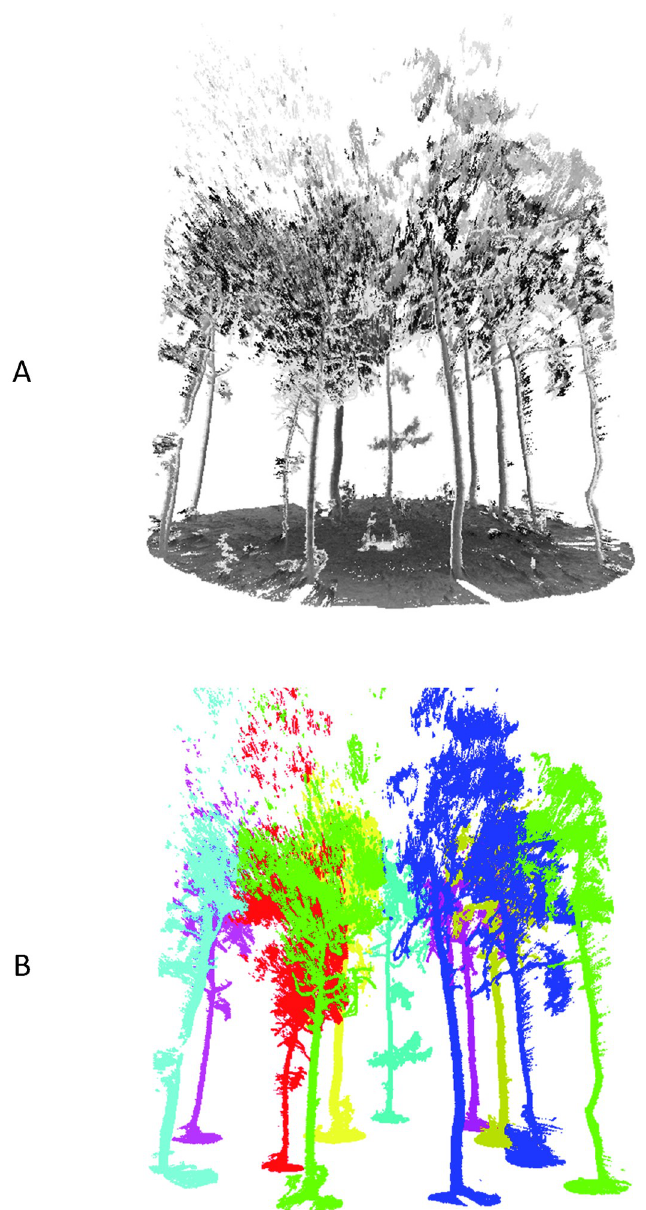
Fig 14. The results of JiuFeng plot1. ( A ) Point cloud data; ( B ) The detected trees.